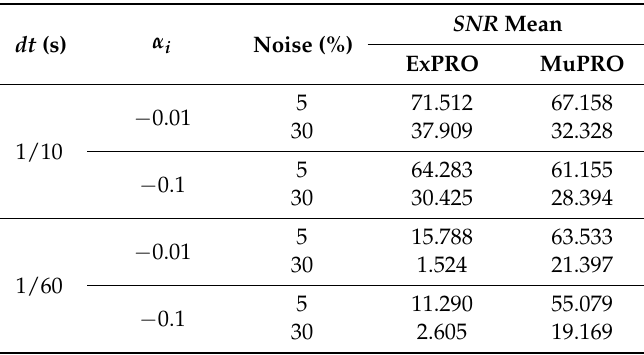
Table 6. Comparison of signal-to-noise ( SNR )